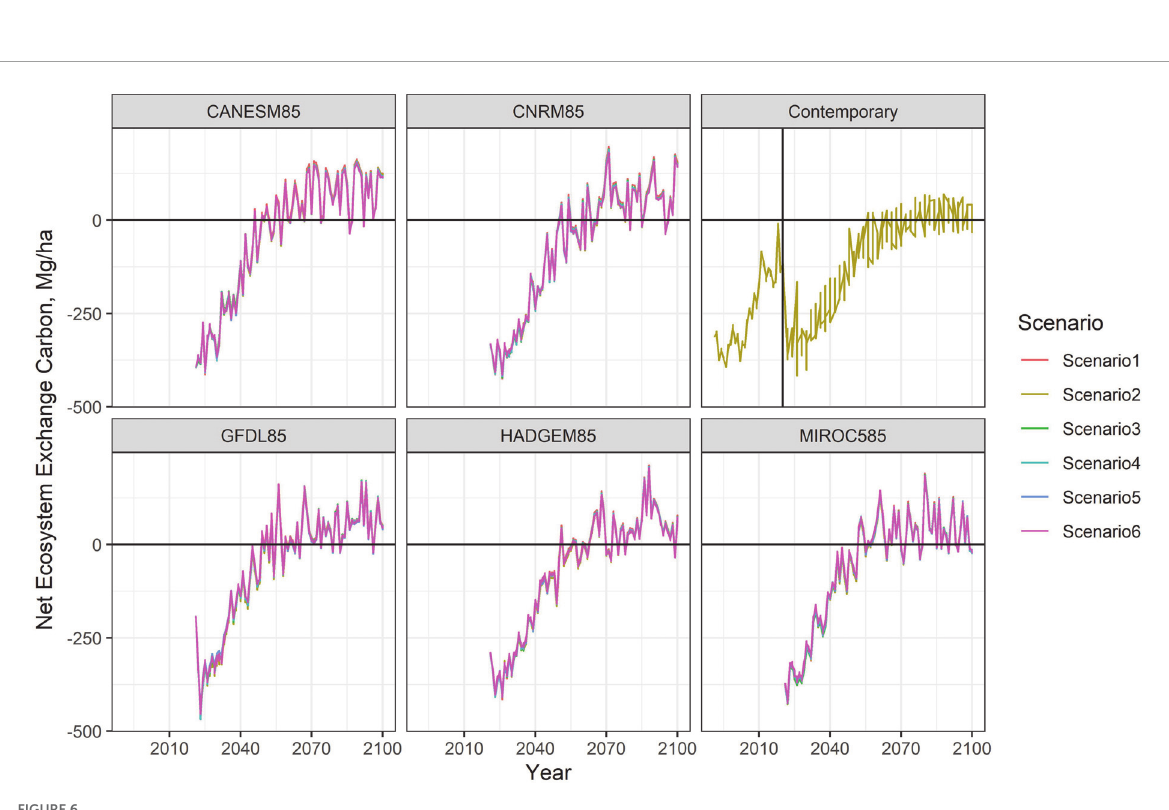
Frontiers in Forests and Global